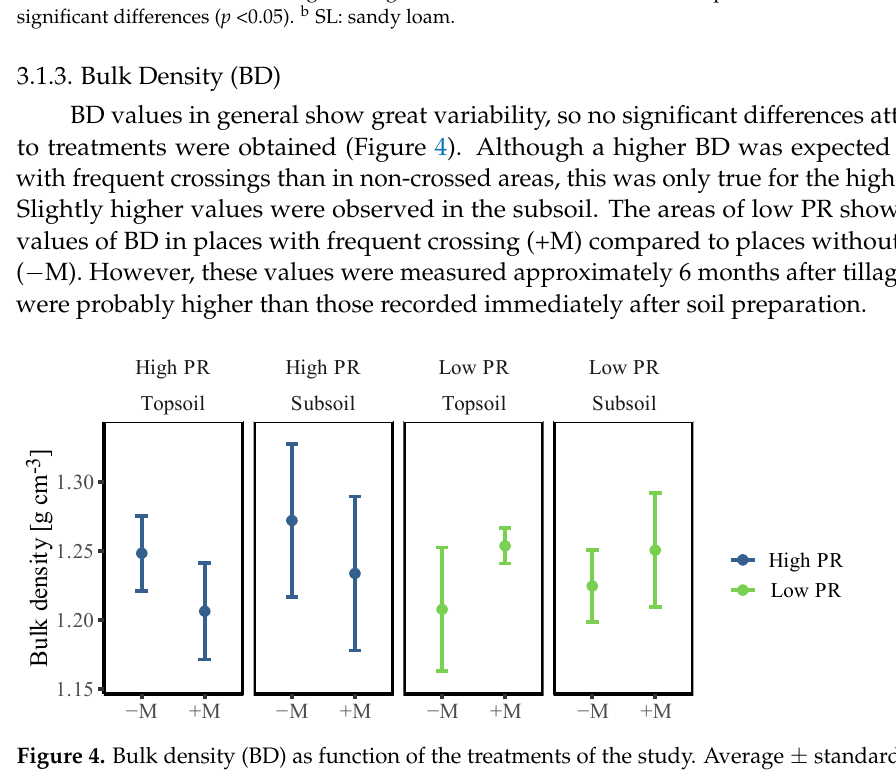
Figure 4. Bulk density (BD) as function of the treatments of the study. Average ± standard deviation values. There were no statistically significant differences ( p > 0.05).